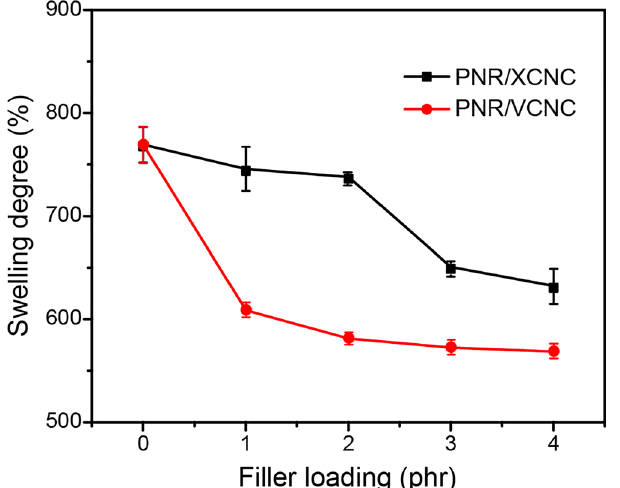
Figure 13. Swelling degree in toluene of the